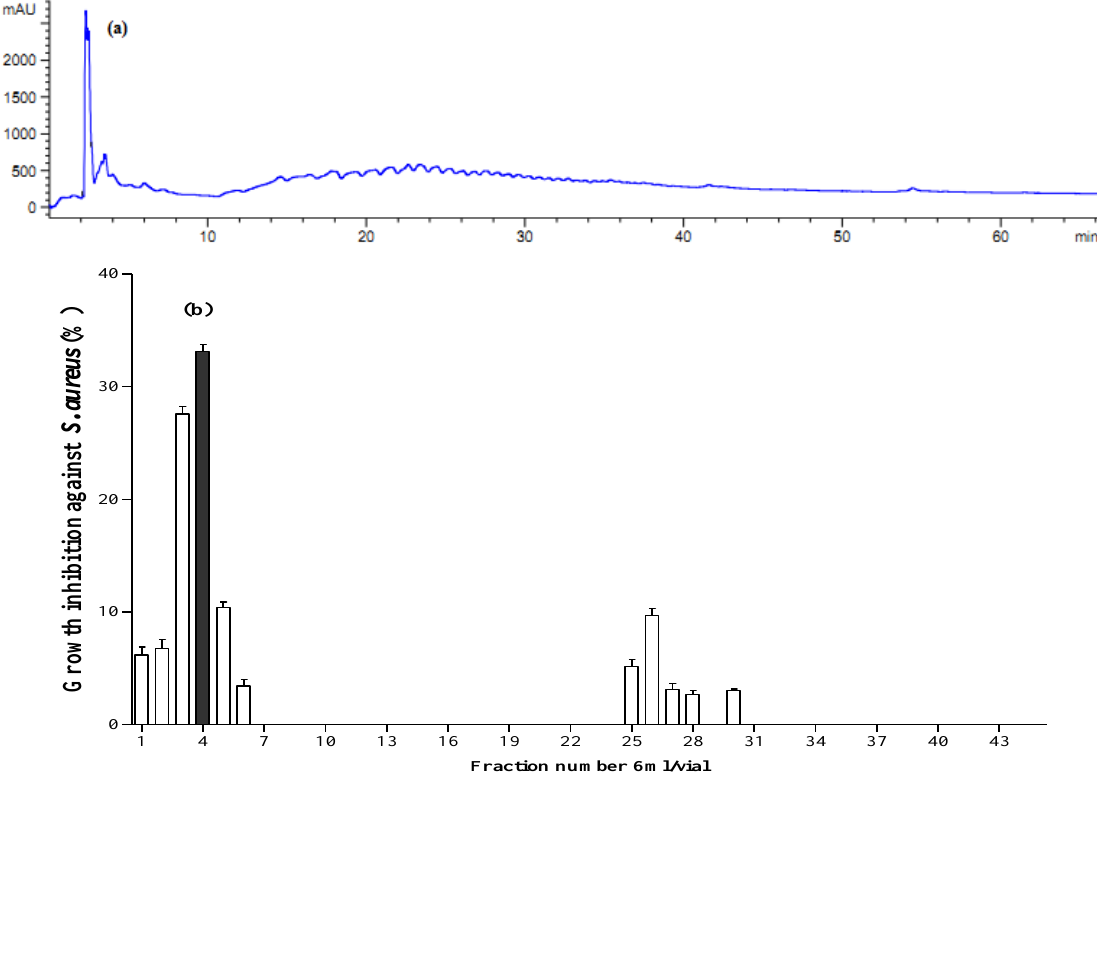
Figure 6. Fractionation of A. lecanora papain generated hydrolysate (after 8 h hydrolysis) by semi-preparative RP-HPLC. ( a ) Chromatogram of A. lecanora hydrolysate; and ( b ) Growth inhibition (%) of collected fractions against S.